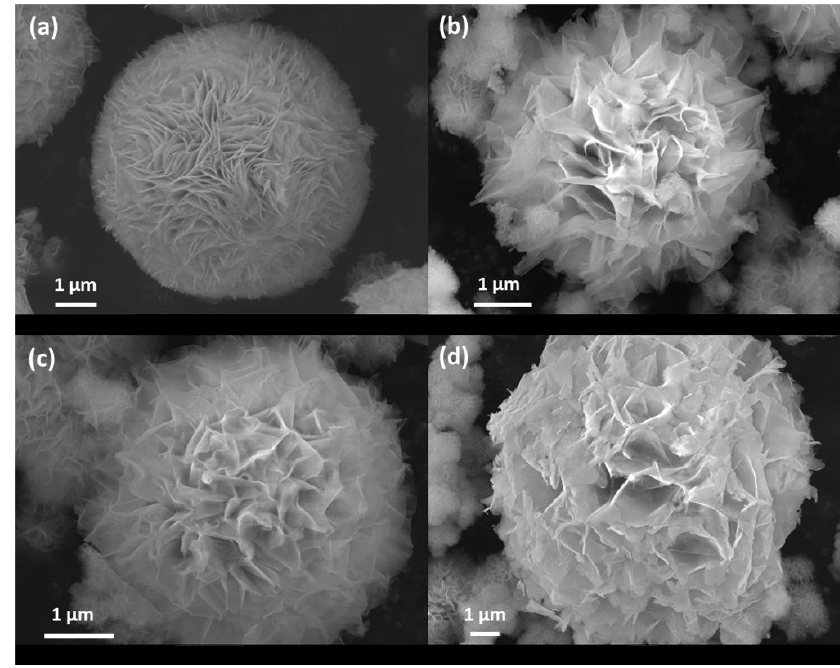
Figure 2. SEM of ( a ) DI-120, ( b ) EG-120, ( c ) EG-150 and ( d ) EG-180. 2.2. Comparison on Photocatalytic Activities of Different ZnIn 2 S 4 Photocatalysts To evaluate the photocatalytic performance of different ZnIn 2 S 4 photocatalysts, the removal efficiencies of Cr(VI) under visible light irradiation were investigated. First, adsorption removal in the dark by different ZnIn 2 S 4 photocatalysts was studied. Figure S3 shows that only less than 5% of Cr(VI) can be removed in the adsorption processes. When exposed to visible light for 30 min, the removal efficiencies of Cr(VI) by DI-120, EG-120, EG-150, and EG-180 are 53.3%, 94.3%, 57.1%, and 78.4% (Figure 3a). The result indicates that Cr(VI) is mainly removed by the photoreduction action of different ZnIn 2 S 4 due to the highest valence state of chromium and the limited adsorption effect of ZnIn 2 S 4 . Photocatalytic processes by DI-120, EG-120, EG-150, and EG-180 all obey the first order dynamic models and the kinetic constant in EG-120 process is 4, 3.43, and 1.85 times than that in DI-120, EG-150, and EG-180 processes, respectively (Figure 3b). The result shows that ZnIn 2 S 4 prepared via solvothermal process in 120 °C exhibits the excellent photoreduction activity, which is inconsistent with the previous study [15]. This may be due to the different raw materials, resulting in different effects of solvents on the photoreduction performance of ZnIn 2 S 4